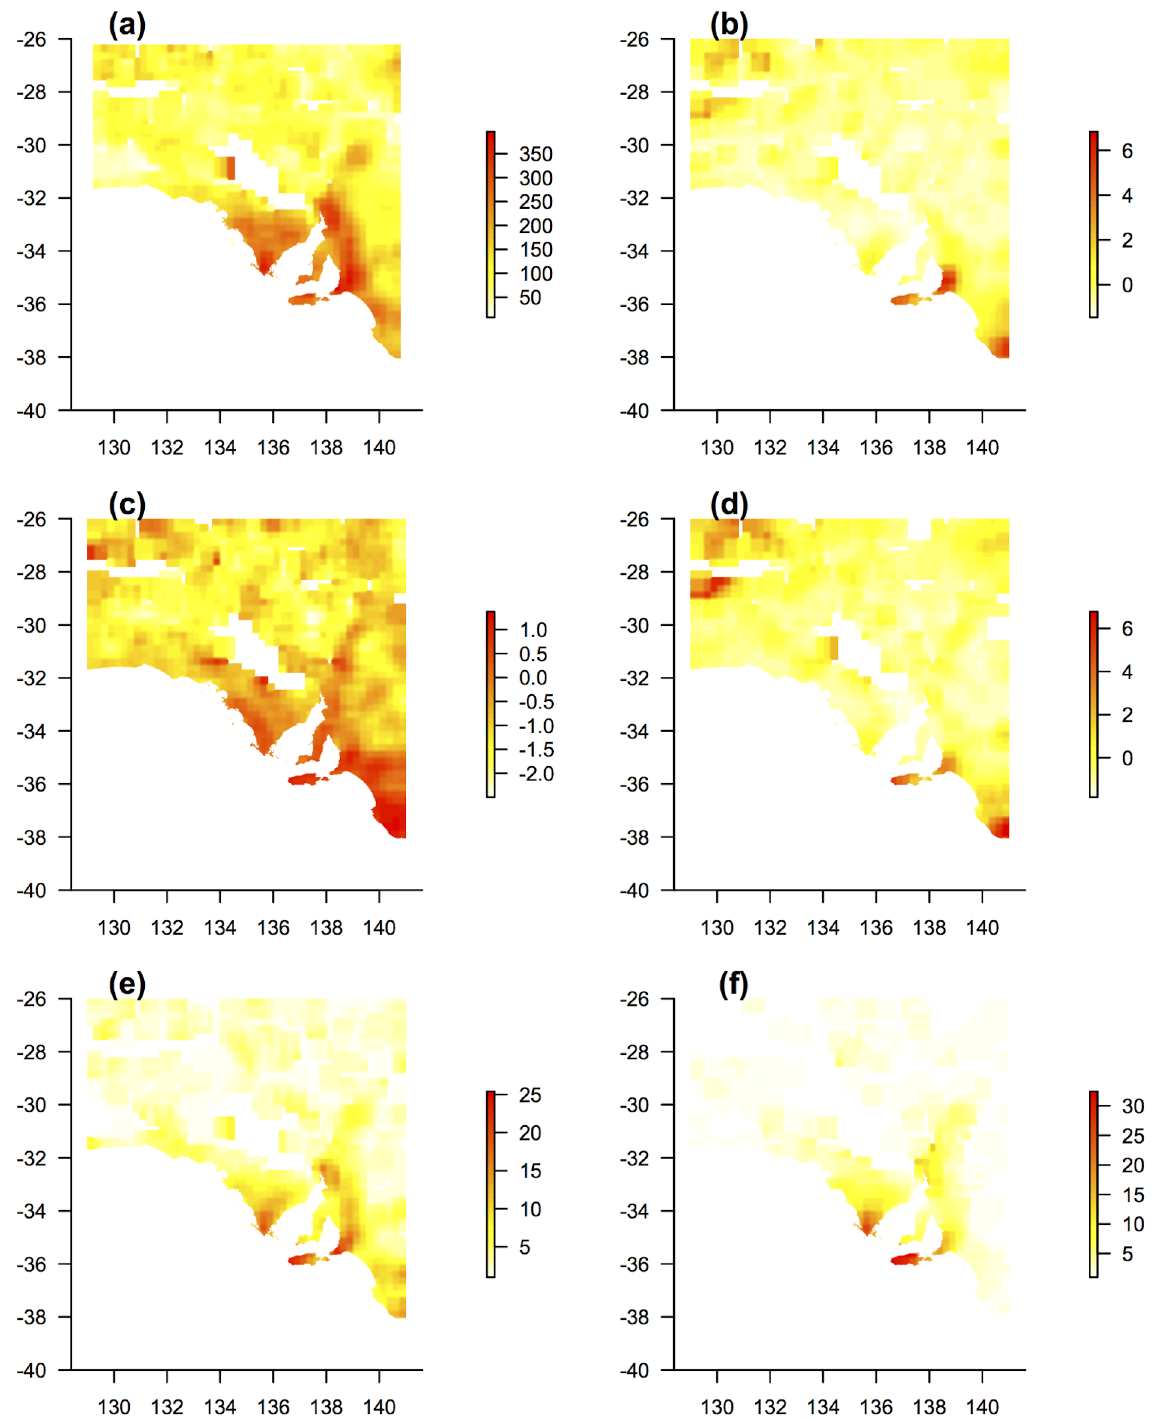
Fig 2. Maps of measured biodiversity metrics. Maps are smoothed at a resolution of 1 km 2 with values given per surrounding 0.25° x 0.25° area: (a) Estimated species richness based on non-parametric estimator (plot data); (b) georeferenced weighted endemism of native species (plot data) – continuous outlier metric; (c) phylogenetic diversity (plot data) – continuous outlier metric; (d) georeferenced phylogenetic endemism (plot data) – continuous outlier; (e) species richness of conservation-dependent species (plots); (f) species richness of categorical South Australian endemics (plot data).